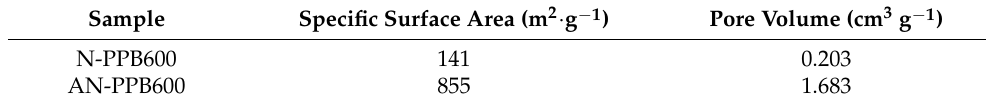
Table 3. Specific surface area and pore volume of N-PPB600 and AN-PPB600. Sample